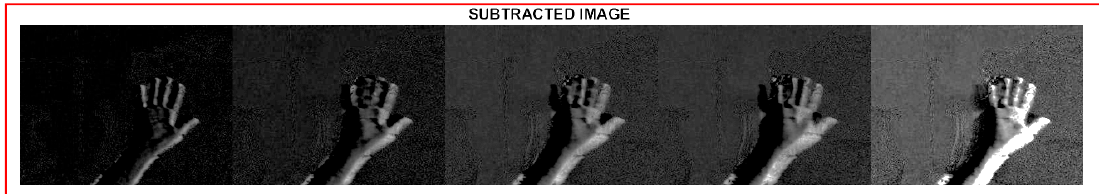
Figure 8. Example on motion recognition using frame difference subtraction to extract hand feature, where the moving object such as hand extracted from the fixed background.